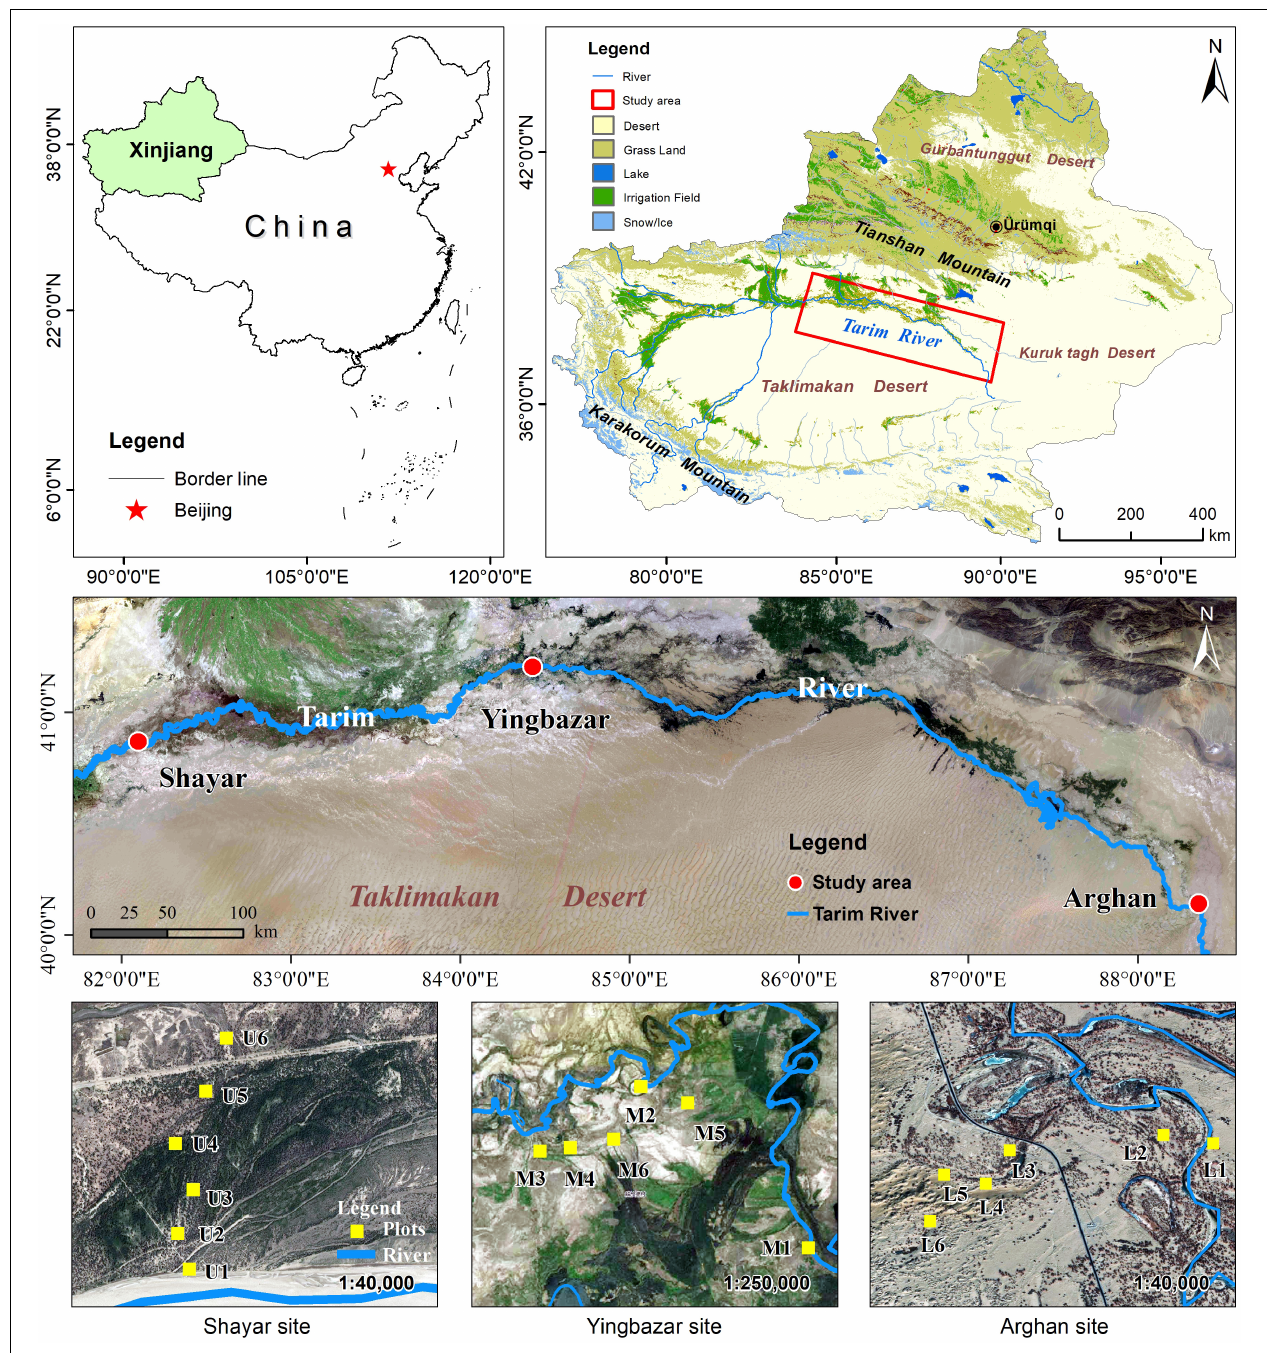
FIGURE 1 | Map of the study area and location of sampling sites.